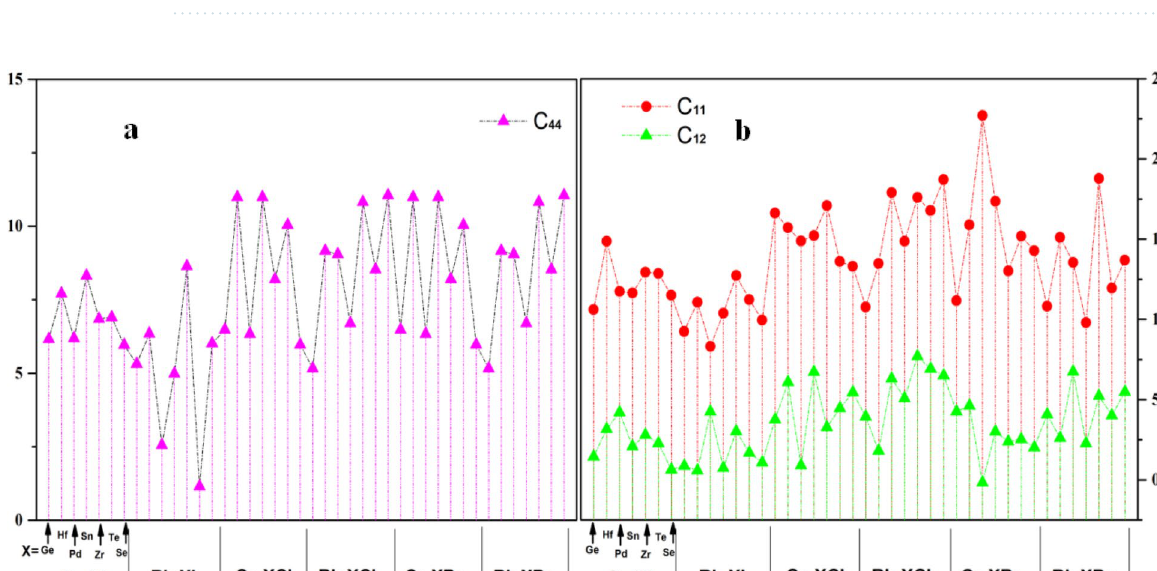
Table 4. Elastic moduli of bromide inorganic perovskites.